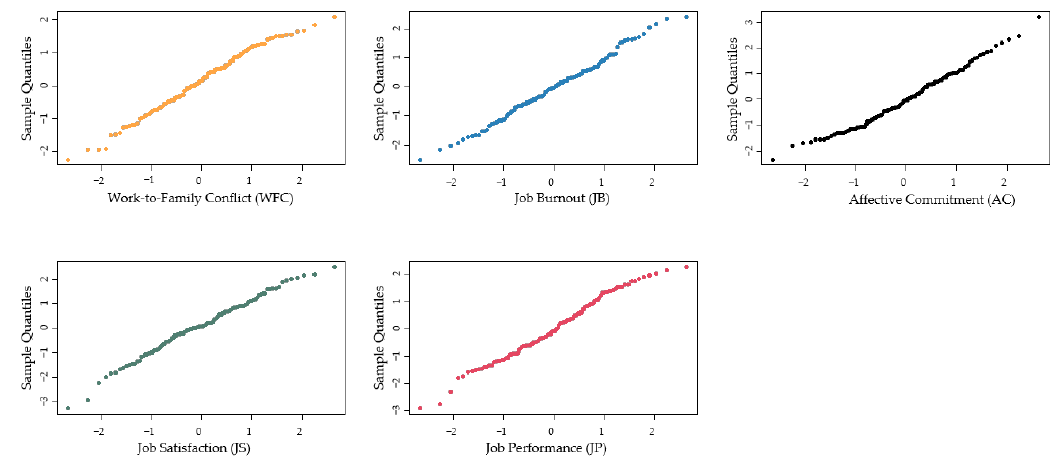
Figure 2. The results of t he normality test.